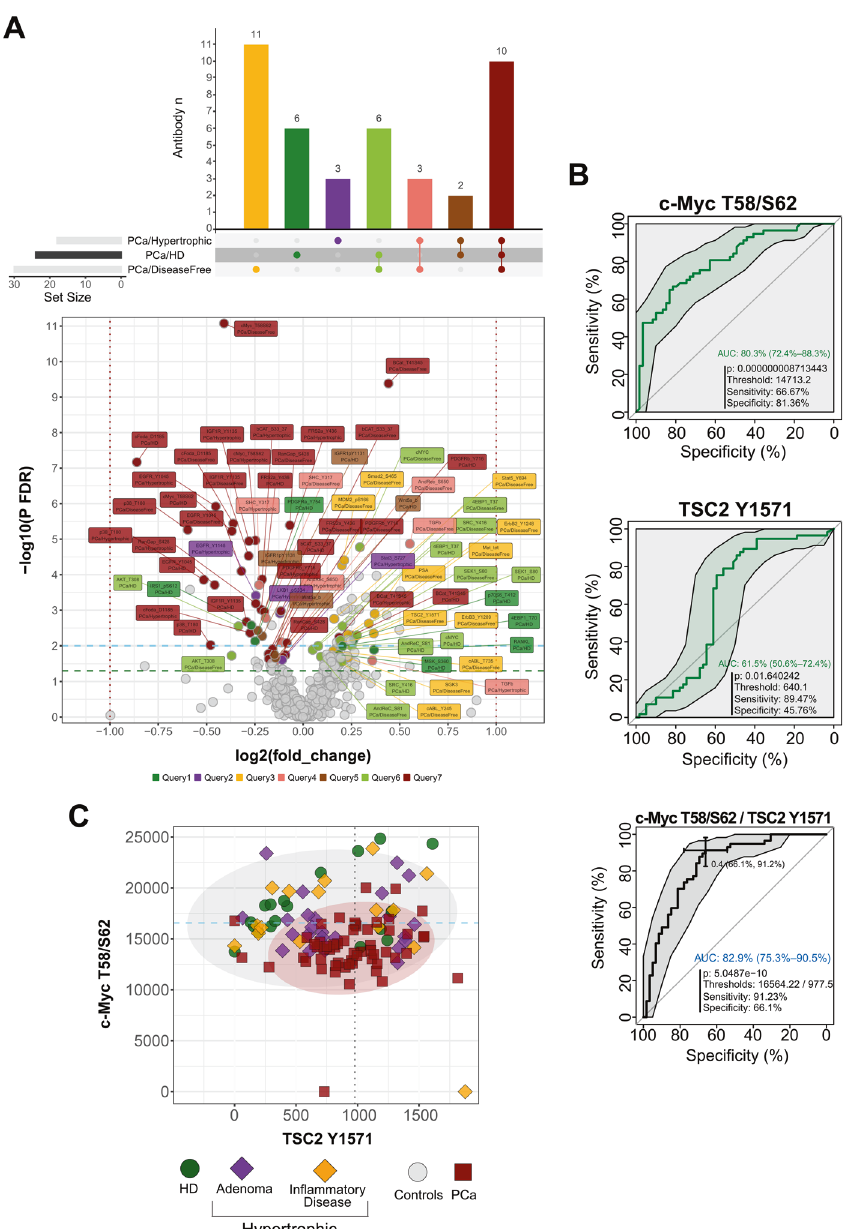
Fig. 4 Group comparisons and biomarker analysis on the training cohort. A Combined Up Set [94] and volcano plots, with color-coded annotations of diverse RPPA endpoint sets that characterize speci fi c binary comparisons of sample groups. The vertical histogram (upper panel) reports the relative frequency of unique (single dots) and shared (connected dots) signi fi cant RPPA antibodies resulting from three speci fi c sets of statistical comparisons, namely PCa versus Hypertro fi c, HD and Post-prostatectomy disease free (DF), respectively. The volcano plot in the lower panel shows fold-changes (log2) versus signi fi cance [ − log10( p - value)] for all analyzed comparison sets (i.e. PCa versus Hypertro fi c or HD or disease-free, respectively). The color-coding ( ‘ queries ’ ) of RPPA antibody labels in the volcano plot matches the corresponding colors sets in the main frequency histogram. The horizontal histogram adjacent to comparison sets (left-bottom part of the upper panel) shows the absolute frequency of statistically signi fi cant RPPA antibodies obtained for each individual set. B Univariate ROC curve analysis of two selected, signi fi cant candidate markers resulting from statistical comparison of controls (grouped HD plus Hypertrophic diseases) and tumors (upper plots). The diagnostic performance of combined top-scoring candidates was further assessed by ROC curve analysis (bottom plot). All plots report the AUC value along with the 95% con fi dence interval as well as p, optimal cut-off, sensitivity and speci fi city values. C Bivariate plot of best candidates (c-Myc T58/S62 and TSC2 Y1571) normalized RPPA intensity values in the analyzed cohort comprising tumors (PCa) and control samples, i.e. HD and Hypertrophic diseases, the latter subdivided into Adenoma and In fl ammatory diseases, being the category ‘ others ’ referred to grouped non-neoplastic samples (controls). The ellipses represent the probability of distribution (95% con fi dence under normality assumption) for the two main comparison groups, namely PCa and